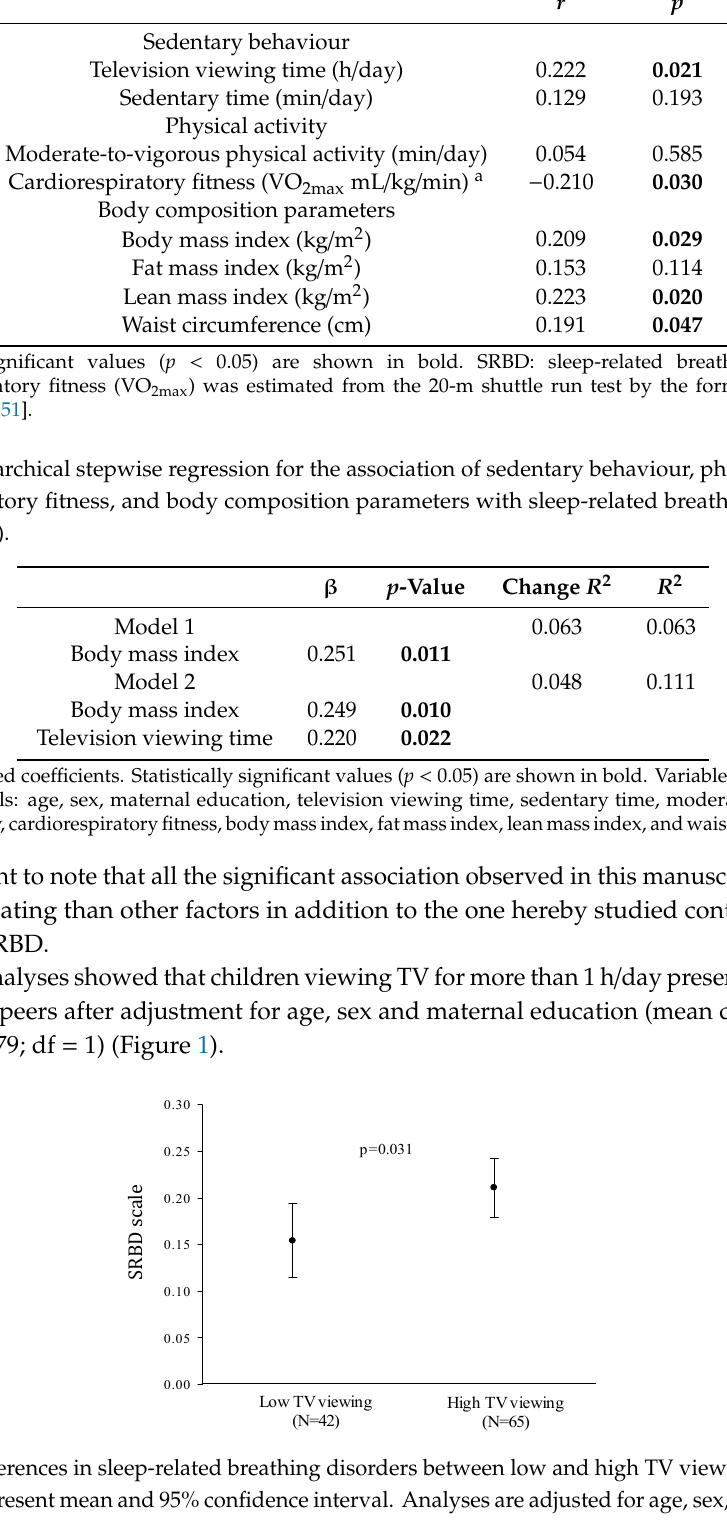
Figure 1. Differences in sleep-related breathing disorders between low and high TV viewing categories. Error bars represent mean and 95% confidence interval. Analyses are adjusted for age, sex, and maternal education. Low TV viewing: ≤ 1 h/day; High TV viewing: > 1 h/day. TV: television. SRBD: sleep-related breathing disorders.